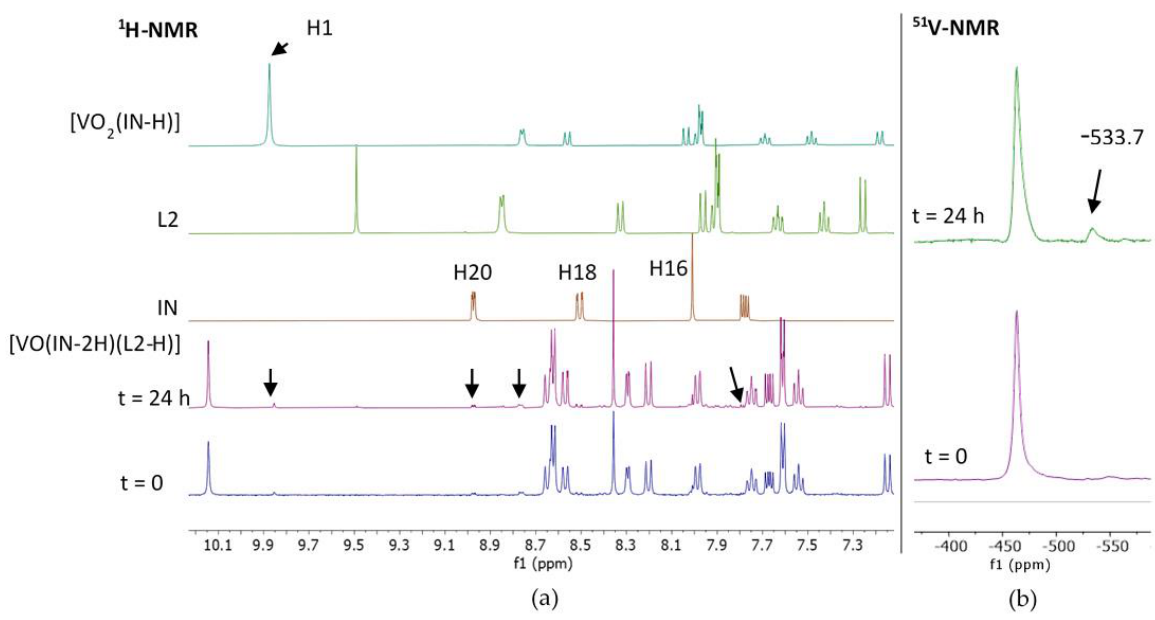
Figure 3. ( a ) 1 H-NMR of [V V O(IN-2H)(L2-H)] in DMSO- d 6 (23.5 mM) at t = 0 and 24 h, compared with 1 H-NMR spectra of free ligands and [V V O 2 (IN-H)]. Selected signals were labeled and pointed with an arrow in the spectra of the heteroleptic complex. ( b ) 51 V-NMR of [V V O(IN-2H)(L2-H)] in DMSO- d 6 (23.5 mM) at t = 0 and 24 h.